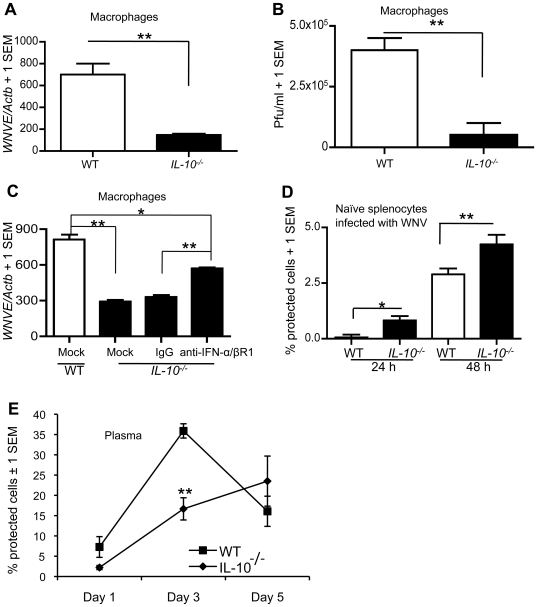
Type I IFN is associated with inhibition of WNV infectivity in vitro.(A–B) One million thioglycollate-elicited peritoneal macrophages isolated from IL-10−/− and WT mice were infected with WNV (MOI = 1) for 24 hours. (A), WNVE was measured in macrophages by Q-PCR and (B) viral load was measured in media by plaque formation assay. (C), Macrophages from IL-10−/− mice were treated with or without (mock) 20 µg/ml of either normal rabbit IgGs or rabbit anti-IFNα/βR1 IgGs (R&D Biosystems) for 2 h followed by WNV infection (MOI = 1) for 24 h. WNVE was measured in macrophages by Q-PCR. (D), Splenic cells isolated from naïve WT and IL-10−/− mice were infected with WNV (MOI = 0.5). Type I IFN level in the medium was measured by IFN bioassay. (E), WT and IL-10−/− mice were inoculated with WNV (LD50, i.p.) and type I IFN level was measured by IFN bioassay. *p<0.05 and **p<0.01.